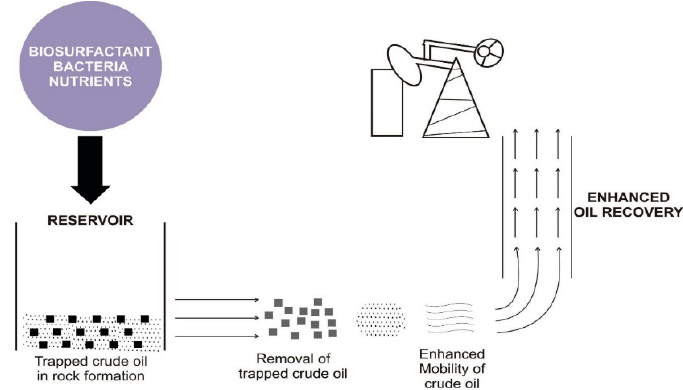
Figure 1. Working principle of biosurfactants in microbially enhanced oil recovery (MEOR).